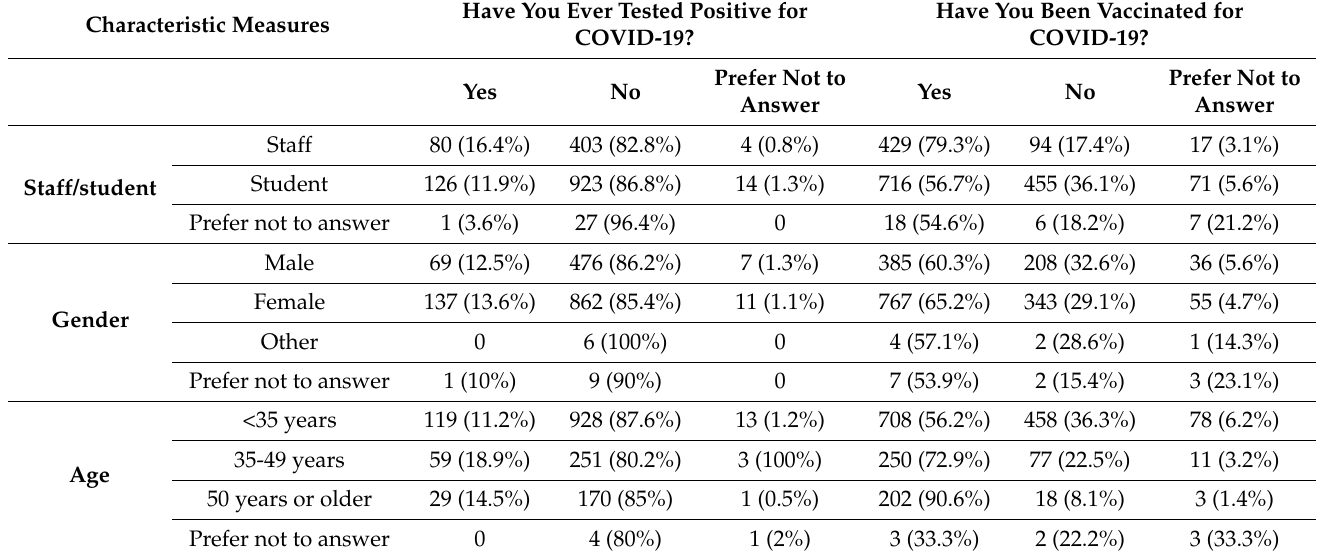
Table 3. Prior COVID-19 testing and vaccination among